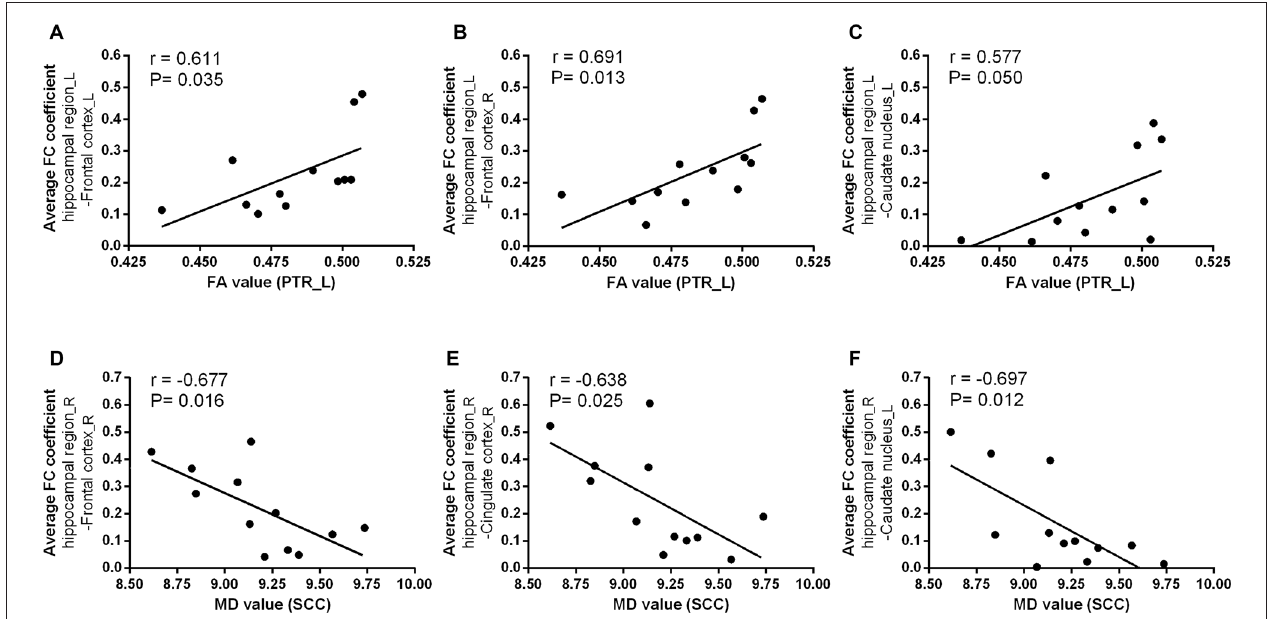
FIGURE 5 | The relationships between WM diffusion metrics and hippocampal FC measures in T2DM. The mean FA values in PTR_L was positively associated with the average coefficient of FC between the left hippocampal region and (A) left frontal cortex; (B) right frontal cortex; (C) left caudate nucleus; The mean MD values in SCC was negatively associated with the average coefficient of FC between the right hippocampal region and (D) right frontal cortex; (E) right cingulate cortex; (F) left caudate nucleus. R, right; L, left. r value means Pearson’s correlation coefficient. P value < 0.05 was considered to be statistically